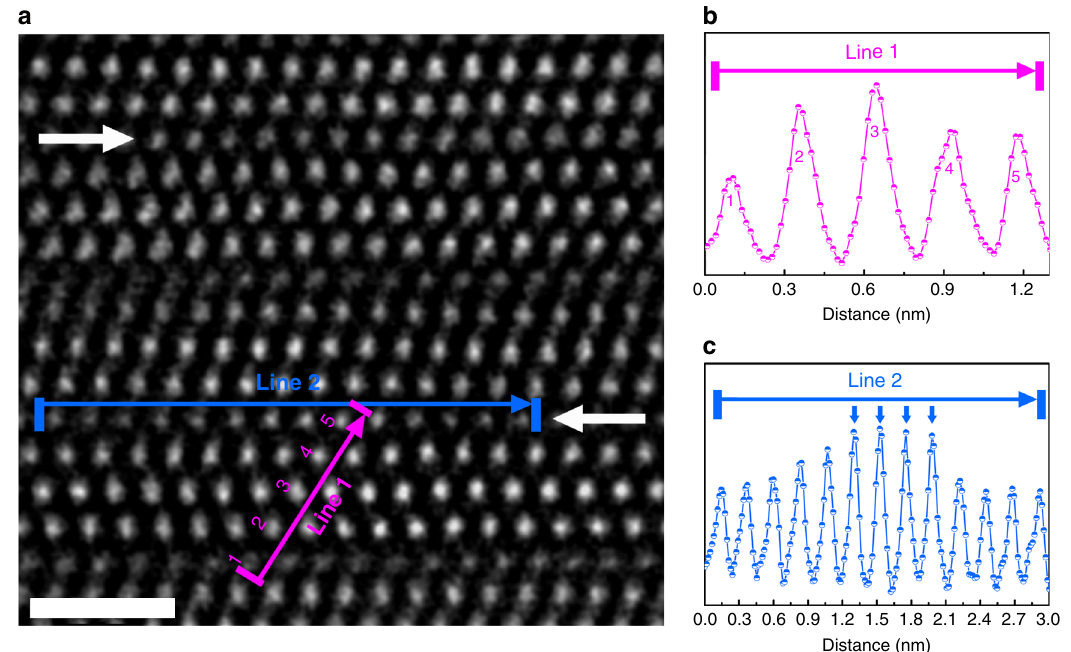
Fig. 2 Direct observation of cation antisite defect. a Scanning transmission electron microscopic high-angle annular dark- fi eld (HAADF) image of Ti 3 AlC 2 (cid:1) (cid:3) after irradiation at 3 × 10 13 cm − 2 along 11 (cid:1) 20 . The white arrows indicate the initial Al layers, whose contrast changed compared to the initial hex-Ti 3 AlC 2 . b – c Contrast pro fi les along lines 1 and 2 in a , respectively, which directly show the variation of the contrast (indicated by the blue arrows) due to the formation of Ti Al -Al Ti antisite defects induced by ion irradiation. The scale bar on the HAADF image correspond to 1